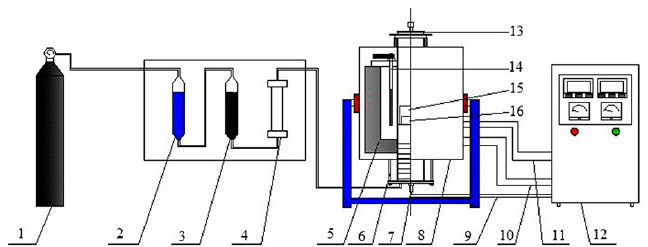
Figure 3. Schematic diagram of smelting separation experimental apparatus (1—argon cylinder;